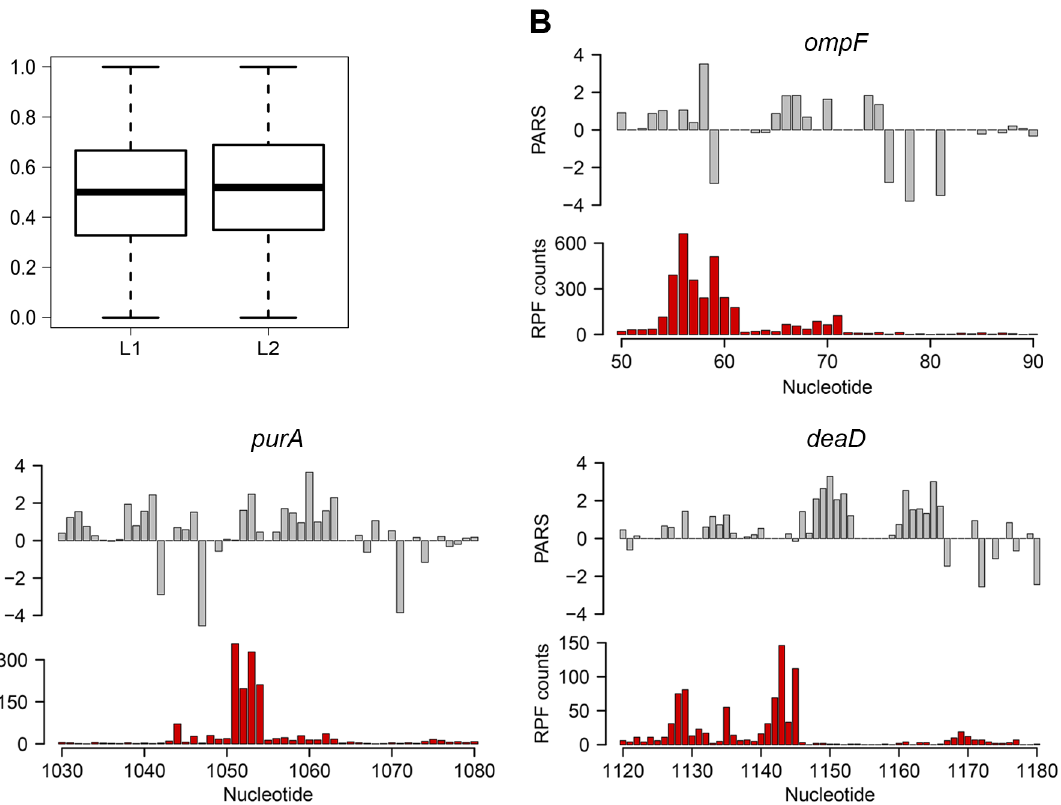
Fig 2. Ribosomal pausing induced by secondary structure in CDS. ( A) Globally, ribosomal pausing is not significantly affected by the presence of secondary structure in the CDS. Box plot analysis of the ratio of RPF upstream (L1) calculated from Eq 2 and downstream (L2) calculated from Eq 3 of detected secondary structures ( P = 0.1209, Kolmogorov-Smirnov test). (B,C) Ribosomal pausing is observed within coding sequences above the 80 th percentile (panel A). Examples of ompF transcript with previously validated secondary structure [65] (B) as well as newly detected genes (C) for which a local secondary structure causes non-uniform ribosomal distribution. Aligned PARS score (upper panel, gray) with the RPF counts (bottom panel, red) at each nucleotide.